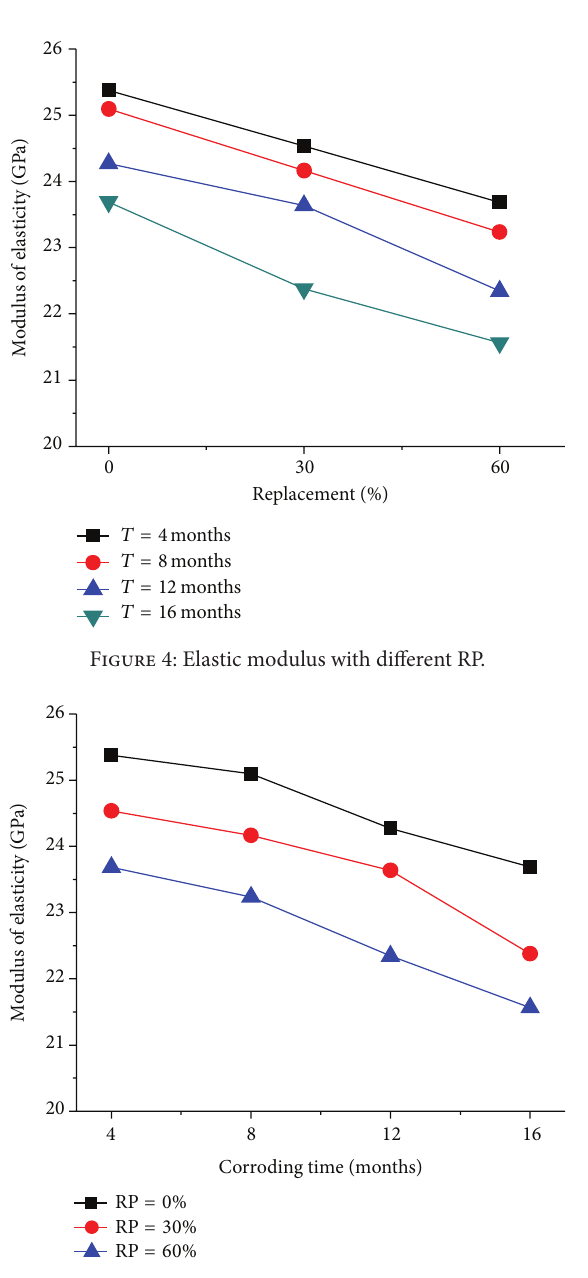
Figure 5: Elastic modulus with different CT.